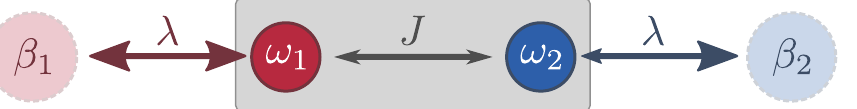
Figure 13: Sketch of a typical non-equilibrium situation with two bosonic modes ω and reservoirs at inverse temperatures β